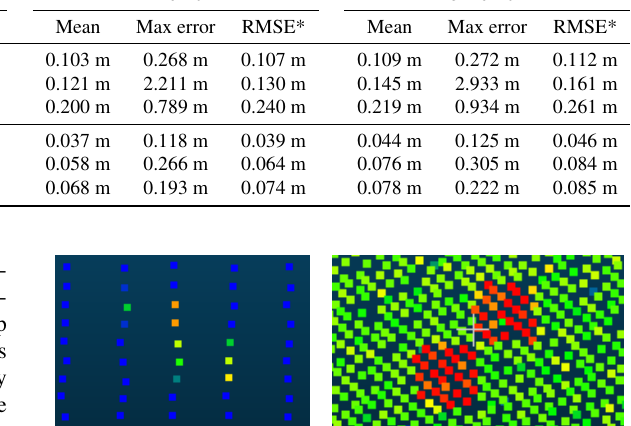
Table 5. Summary of height, 2D and 3D errors for the low-end and high-end mobile mapping system in the different datasets. MMS